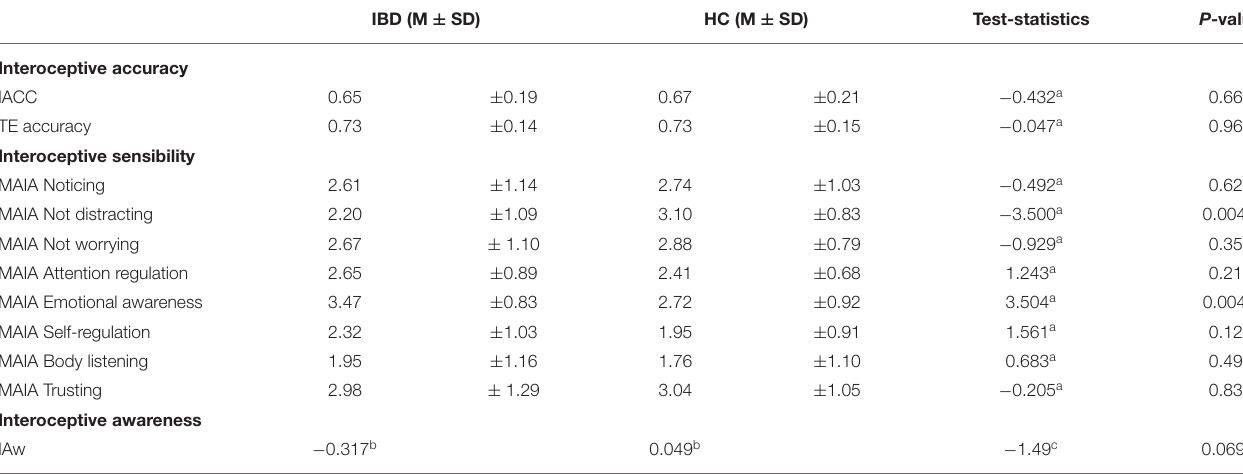
TABLE 3 | Group differences in interoceptive accuracy, interoceptive sensibility and interoceptive awareness.